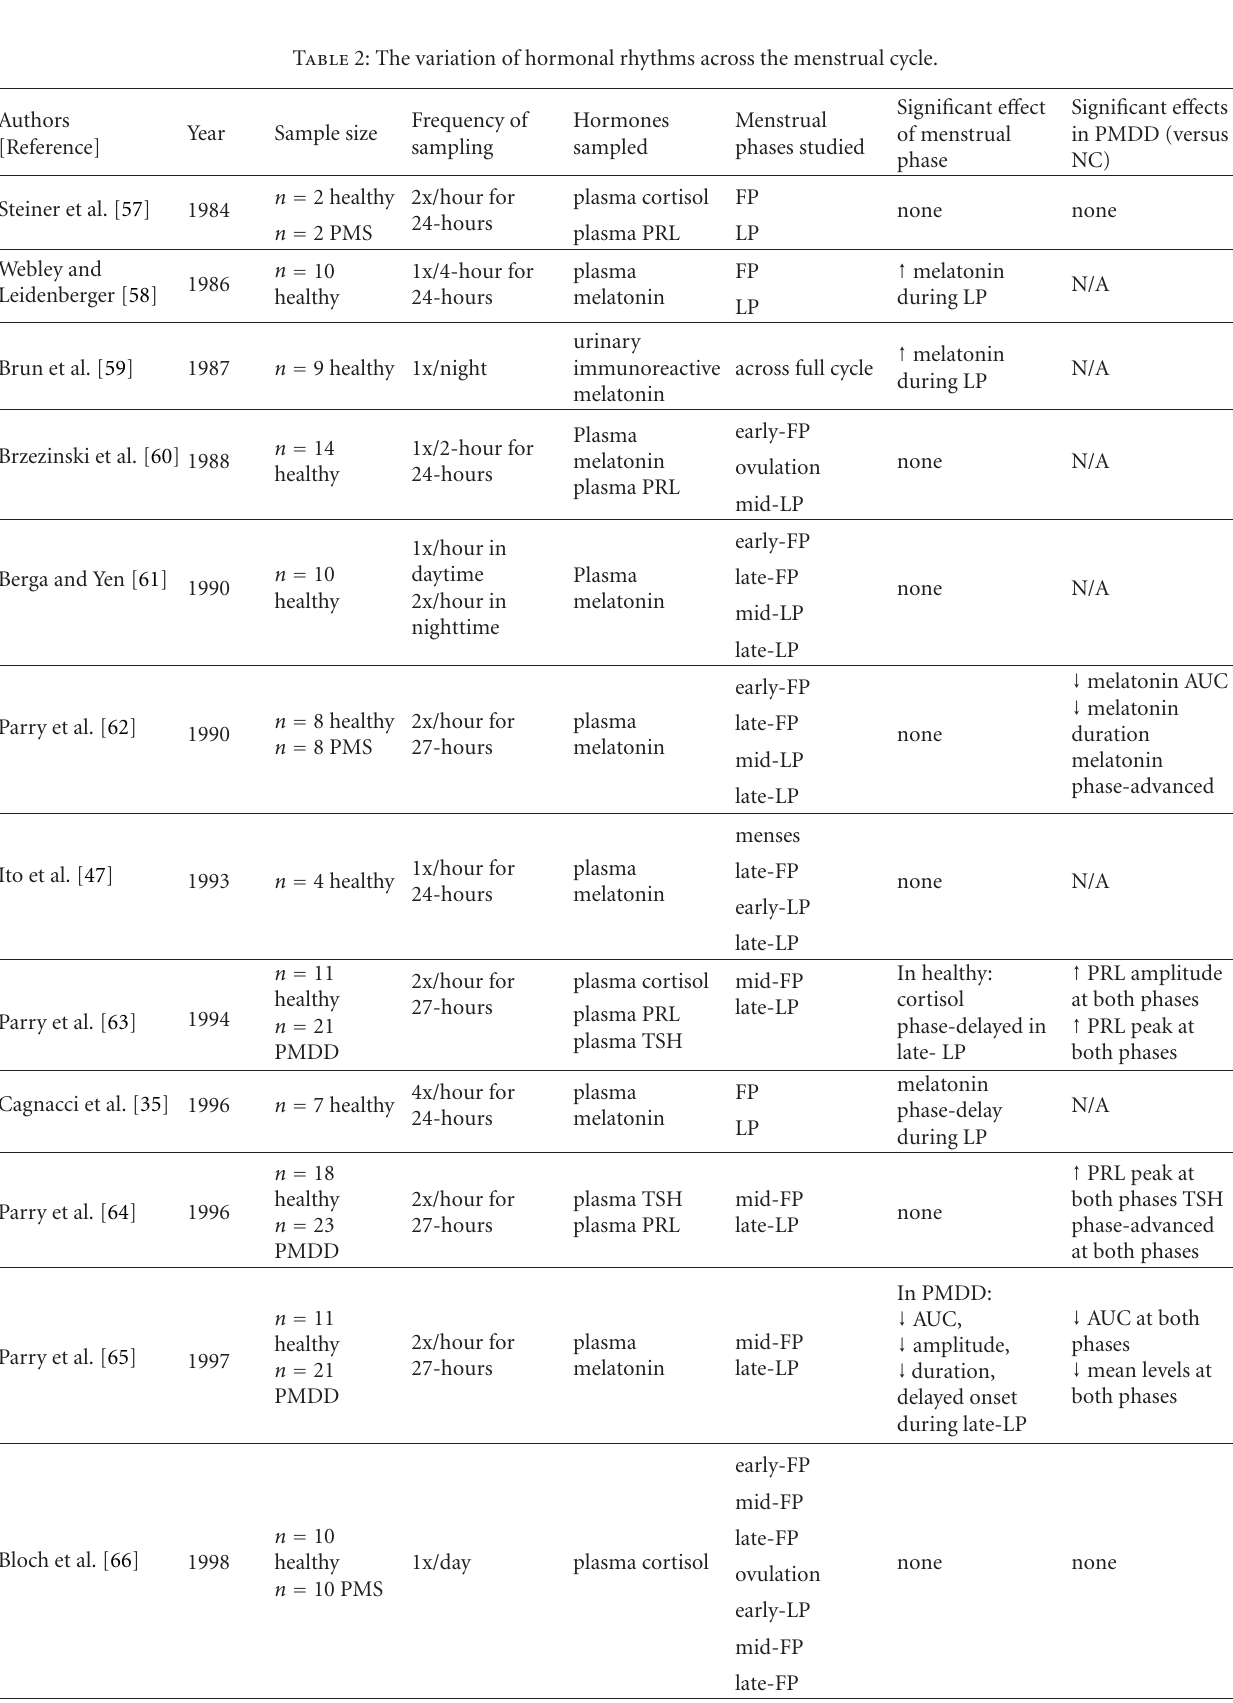
Table 2: The variation of hormonal rhythms across the menstrual